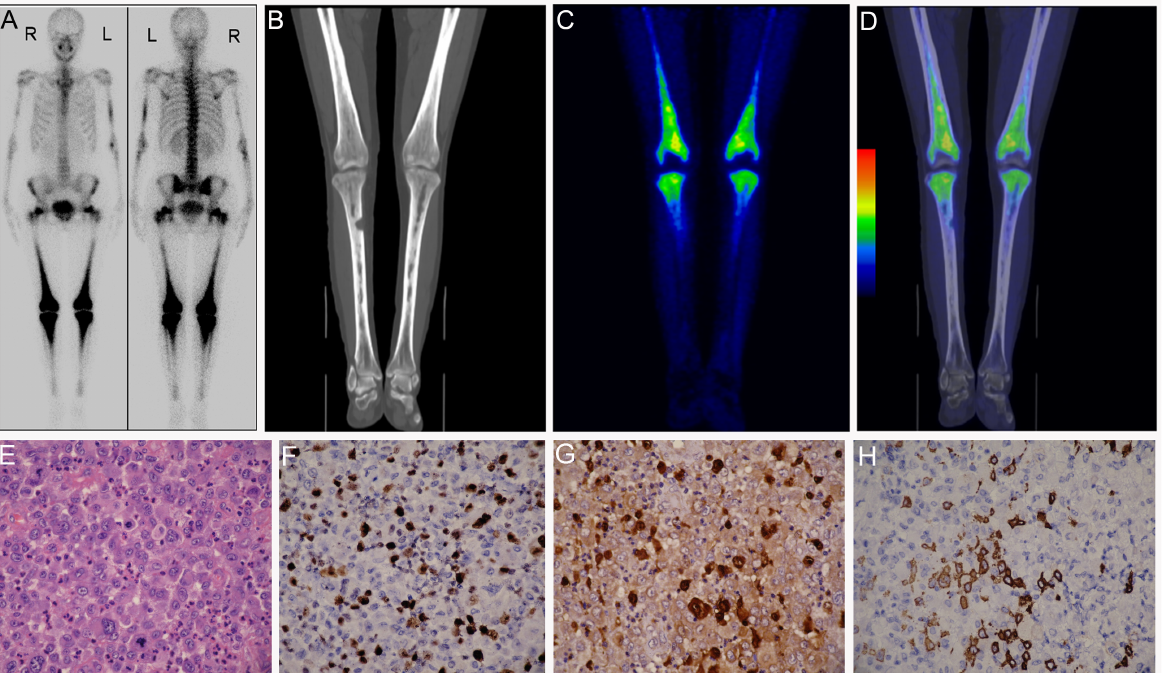
Figure 10. Patient 8: 99m Tc-MDP bone scan ( A ) and 18 F-FDG-PET/CT scan ( B – D ) of the patient. HE staining of the tumor tissue showed that tumor cells have malignant cytologic features and a high mitotic rate ( E ). Immunohistochemistry showed that tumor cells expressed Ki-67 ( F ), S-100 ( G ) and CD1a ( H